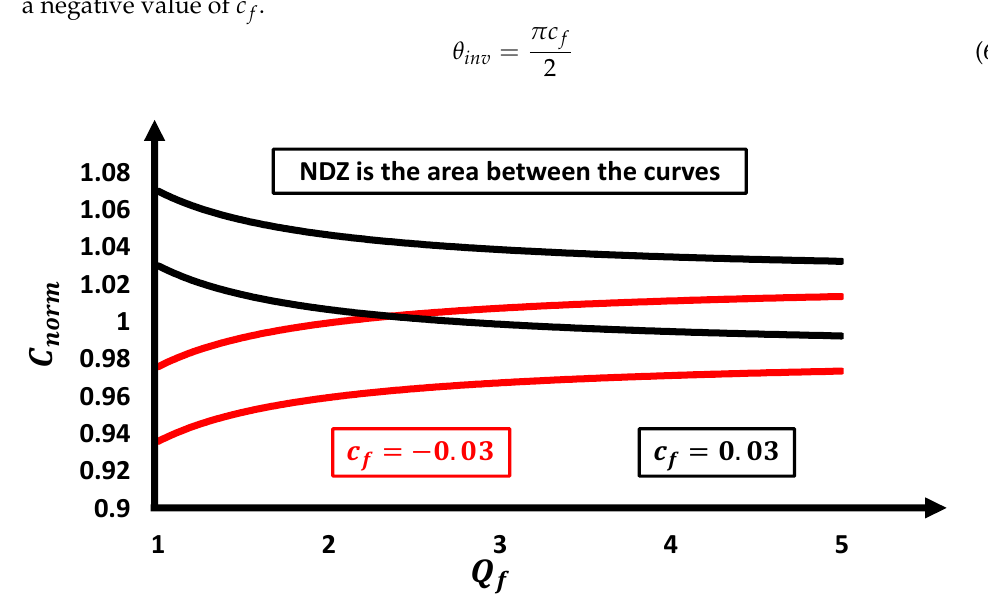
Figure 2. AFD NDZ for different values of 𝑐 𝑓 .